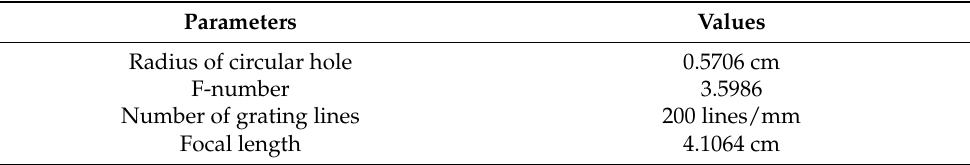
Table 2. Optical system